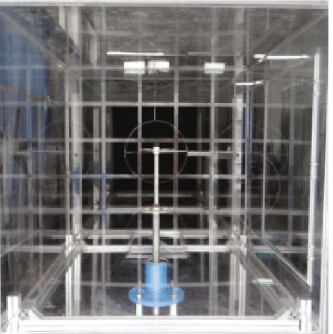
Figure 8: Calibration of the LWC by the grid